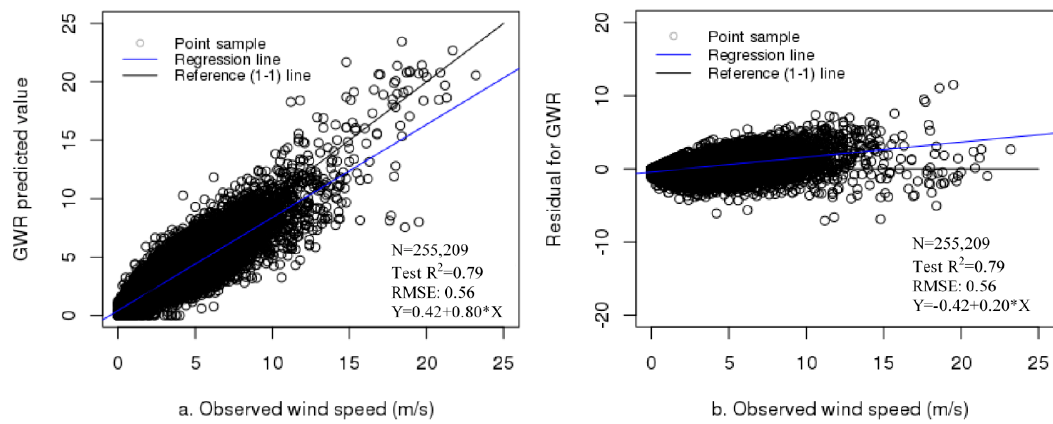
Figure 8. Observed vs. predicted values ( a ) and residual ( b ) plots of wind speed in the test.